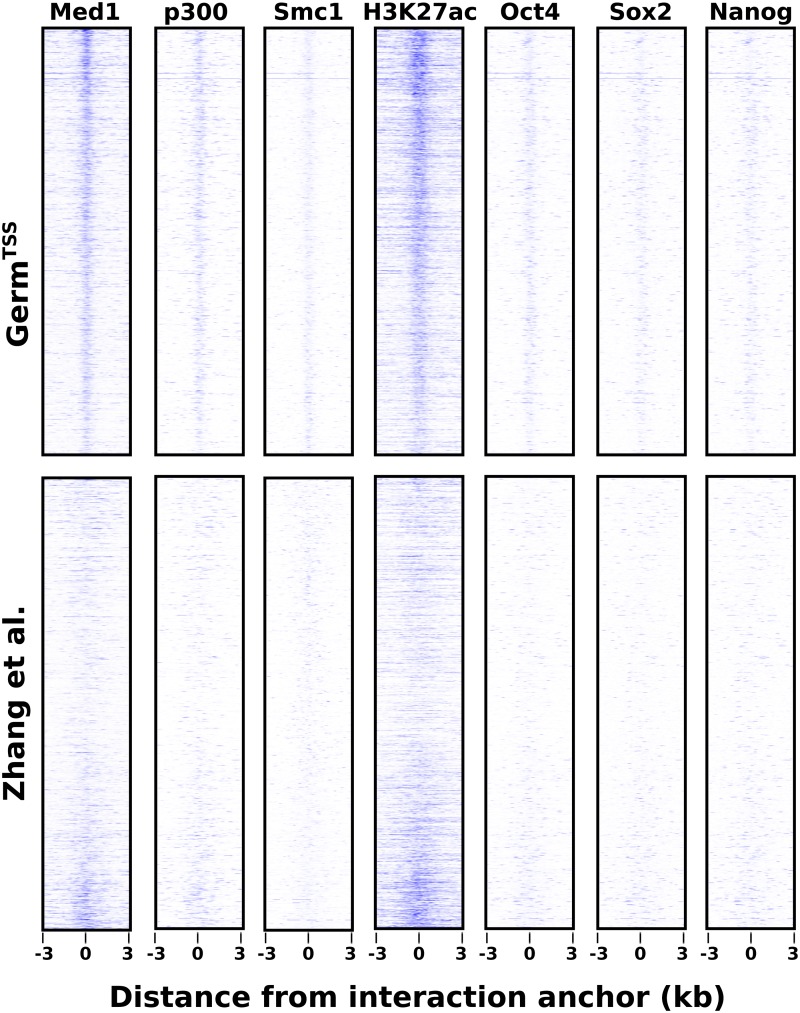
Visualization of ChIP-Seq data in regions detected to interact with TSSs.The top row of boxes contains TSS-distal, TSS jointly occupied regions identified by Germ
TSS. The bottom row of boxes contains the corresponding regions from [27]. The 6 kilobase regions are centered on the estimated eloc or midpoint and are ordered by the significance associated with the interaction. Each column represents data from a ChIP-Seq dataset that is associated with active enhancers.